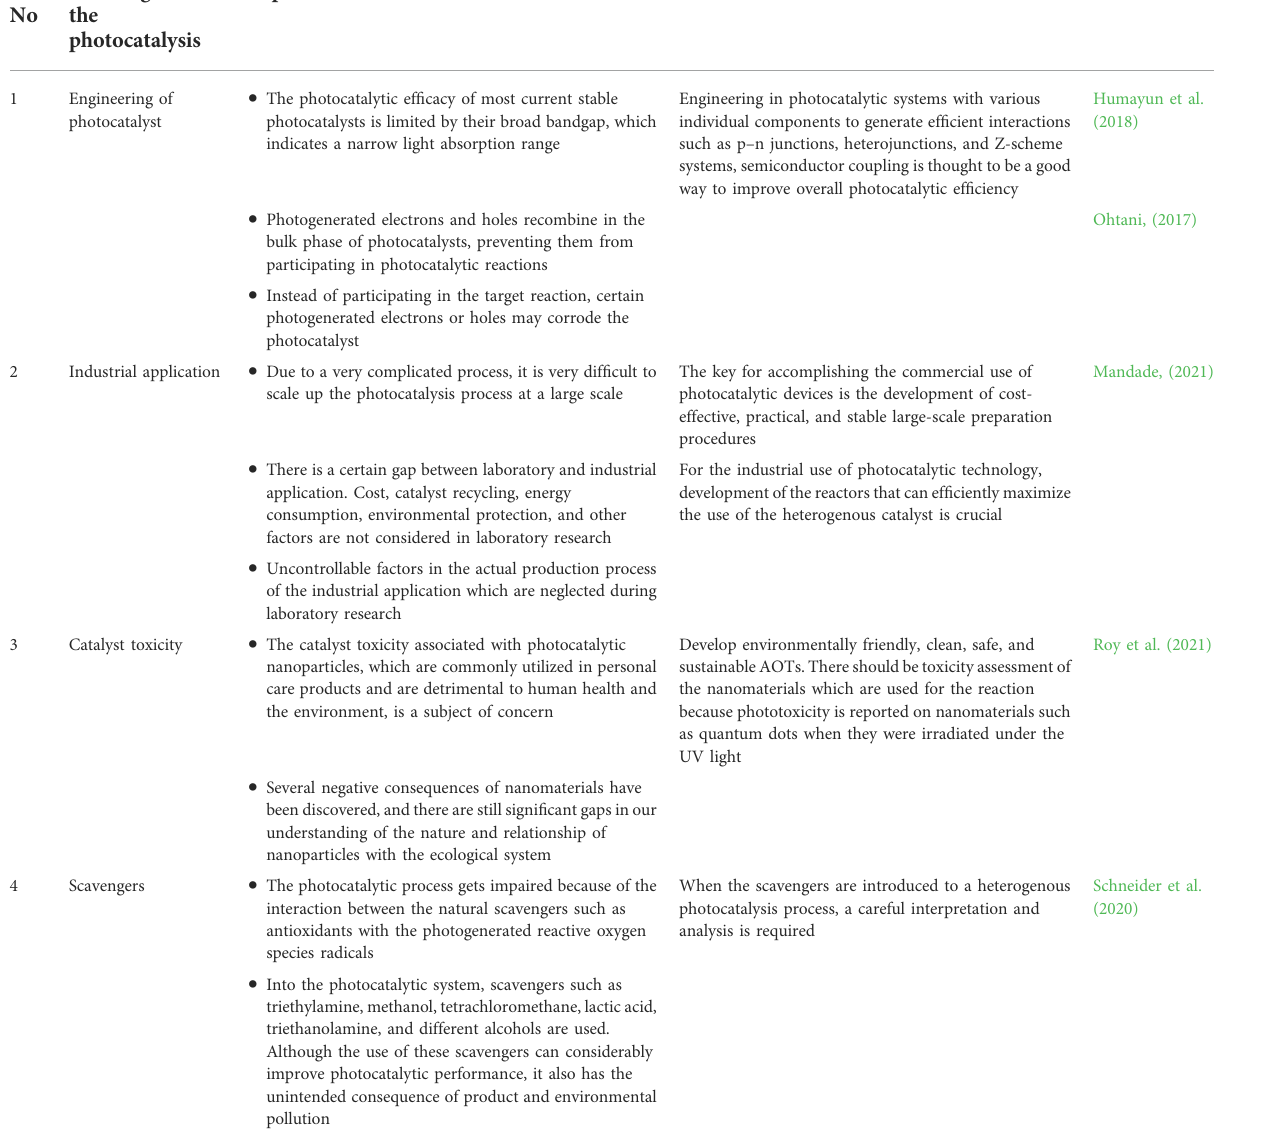
TABLE 5 Different challenges that come during the process of